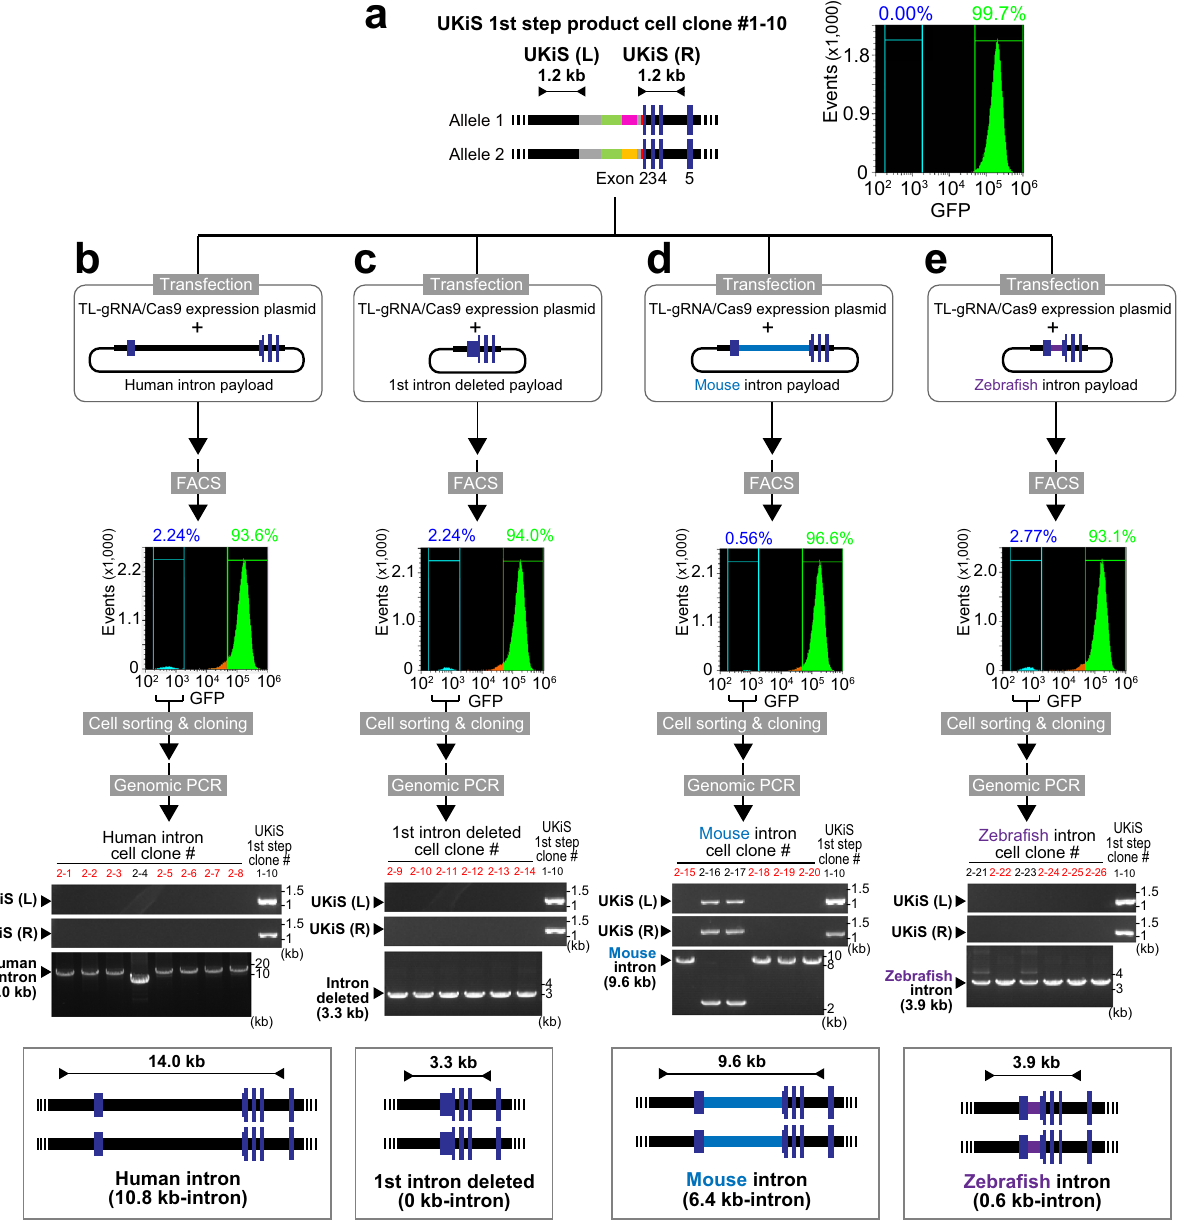
Fig. 3 The second step of UKiS: replacement of UKiS donor alleles in the fi rst intron of TP53 with either the wild-type fi rst intron or one of three mutant fi rst introns. a Schematic diagram of UKiS donor alleles in clone #10 (#1 – 10), the marker parts of which are indicated by the same colors as shown in Fig. 1b. Horizontal lines fl anked by two arrowheads represent the target regions for the junction genotyping PCR performed below. Flow cytometric analysis of GFP fl uorescence in clone #1 – 10. Replacement of both UKiS donor alleles with synthetic introns ( b : human TP53 full-length intron, c the entirely deleted intron, ( d ) syntenic mouse intron, ( e ) syntenic zebra fi sh intron) in clone #1 – 10. First, the mutating payload plasmid and TL-gRNA/Cas9 expression plasmid were transfected into clone #1 – 10. Thereafter, GFP-negative cells were collected by FACS and cloned. Biallelic substitution of UKiS markers with the mutating payload plasmid was con fi rmed by junction genotyping PCR that targeted the regions represented by horizontal lines fl anked by two arrowheads in the schematic diagrams of the TP53 locus after successful replacement, with the expected length of PCR genotyping amplicons indicated. In the agarose gel images, lane numbers of clones that underwent successful recombination in both alleles are in red. Source data are provided as a Source Data fi le. TP53 transcription in the context of the native chromatin archi- migrating main band from the zebra fi sh intron corresponded to the tecture. RT-PCR using primers for the fi rst and fourth exons was splicing products lacking the original fi rst intron. Given the overall performed to demonstrate that the human, mouse, and null introns poor sequence homology of the syntenic introns of the three ver- gave rise to a single PCR band of a similar size in every case, tebrates, this high convertibility suggests that these introns may whereas the zebra fi sh intron resulted in two bands (Fig. 5a). DNA share short cis -element(s) for proper splice site determination. sequencing of all the RT-PCR products indicated that the single Sequencing of the minor band from the zebra fi sh intron indicated bands from the human and mouse introns and the slower- that a different 5 ′ -splice site had been used within the fi rst exon NATURE COMMUNICATIONS| (2022) 13:4219